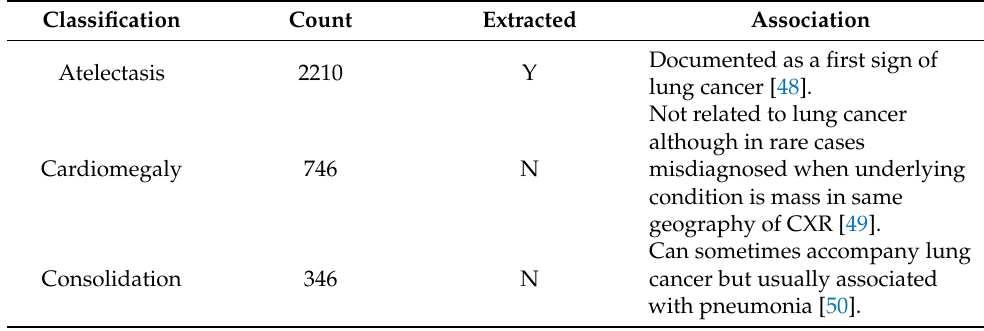
Table 1. Summary of ChestX-ray14 images extracted for deep